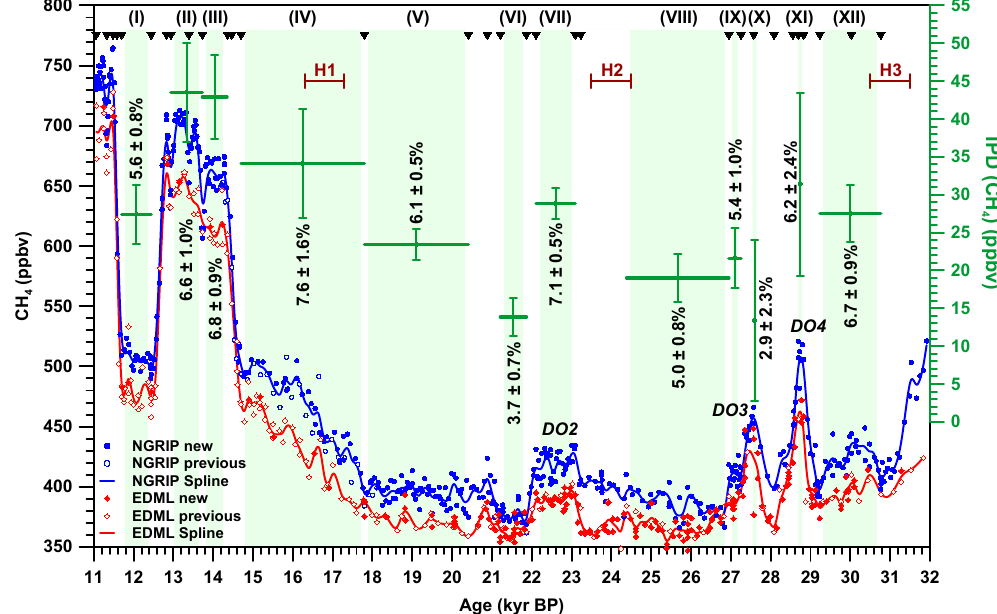
Fig. 1. Atmospheric CH 4 concentration between 32 and 11kyrBP reconstructed from polar ice core measurements. Data from Greenland (NGRIP) are plotted as blue circles and data from Antarctica (EDML) as red diamonds. Earlier published data (NGRIP from Schilt et al. (2010a) and EDML from EPICA Community Members, 2006) are shown as open symbols. The splines through the data are calculated according to Enting (1987) with a cutoff period of 350yr. Mean IPD values (Table 1) are in green, where the horizontal bar and the green shaded area indicate the time interval and the vertical error bar shows the standard error of the mean. Corresponding relative interpolar difference (rIPD) values are indicated as black numbers. Heinrich Events (H) 1 to 3 (Hemming, 2004) are indicated in brown. Tie points for synchronisation (Sect. 2.1) are indicated on the top as black triangles. All CH 4 concentrations are synchronised to the unified EDML gas age scale derived by Lemieux-Dudon et al.